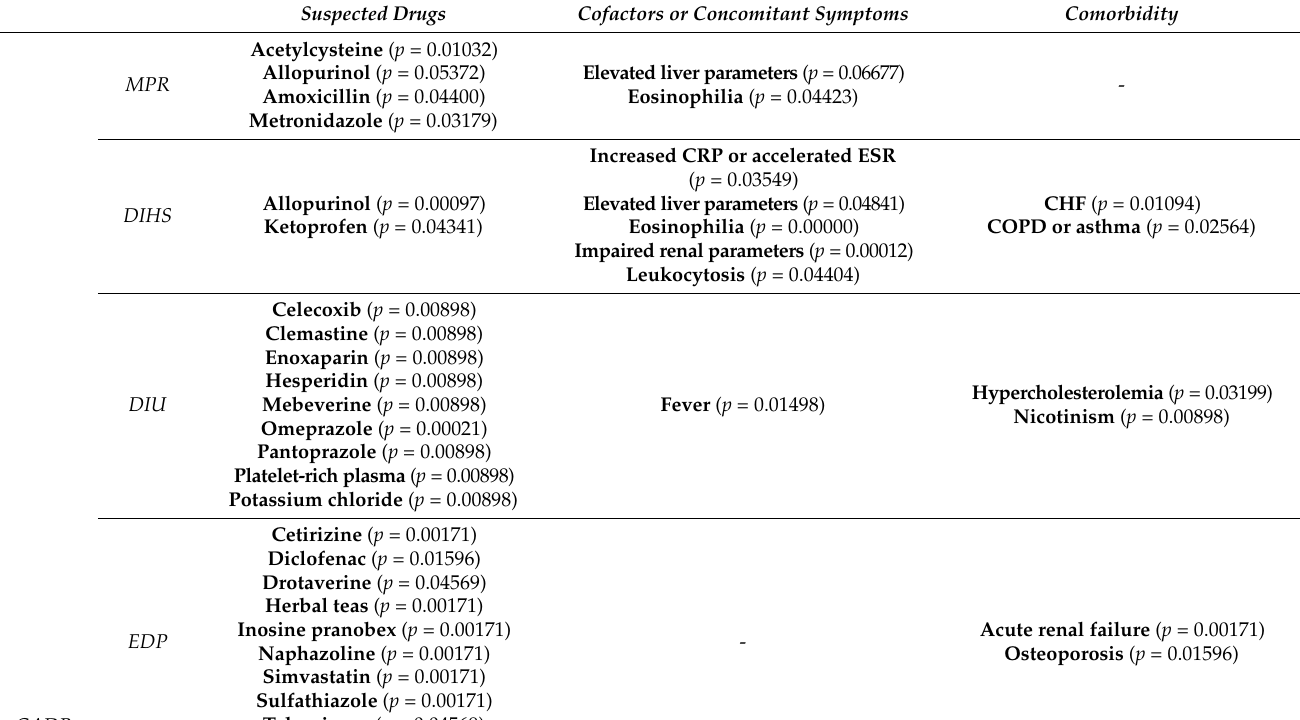
Table 4. Statistically significant factors influencing the emergence of CADRs.